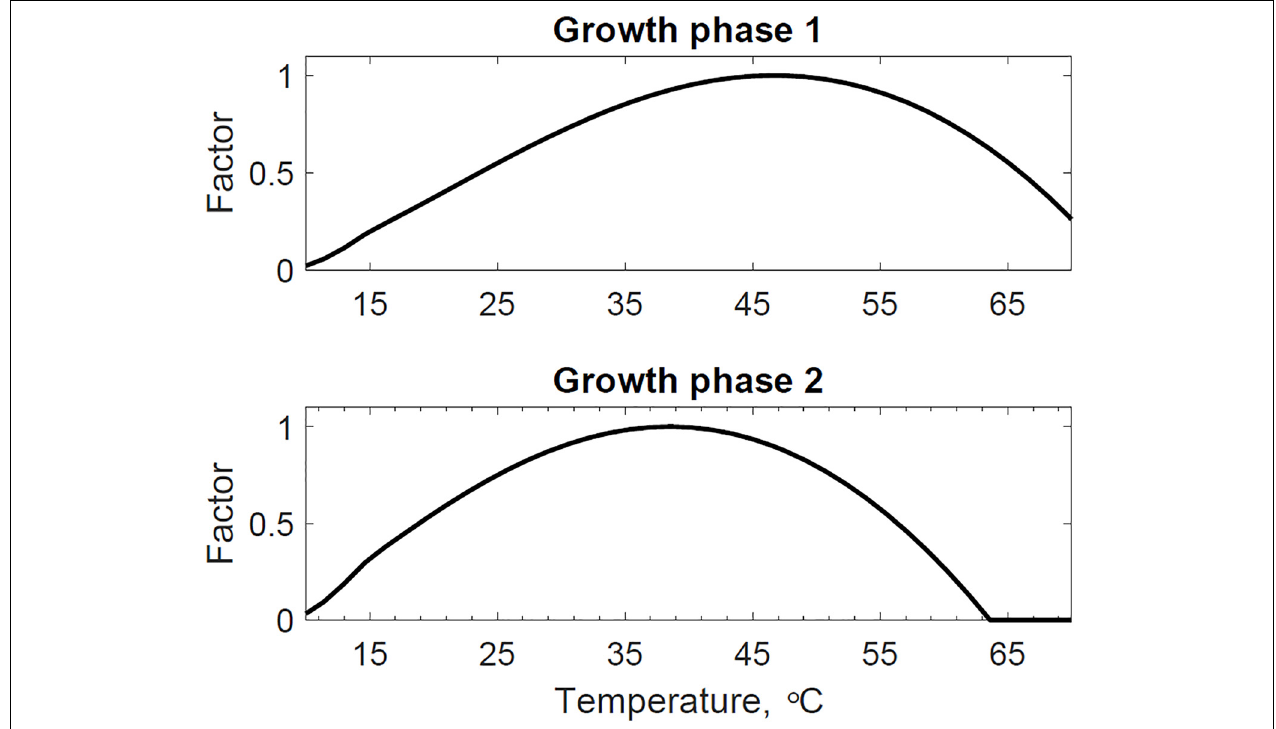
FIGURE 5 | Reactor 2 calibrated cardinal temperatures for two growth phases. The first growth phase optimum, minimum, and maximum temperatures are 46.7, 4.4, and 73.6 ◦ C. The second growth phase optimum, minimum, and maximum temperatures are 38.5, 5.1, and 63.6 ◦ C.